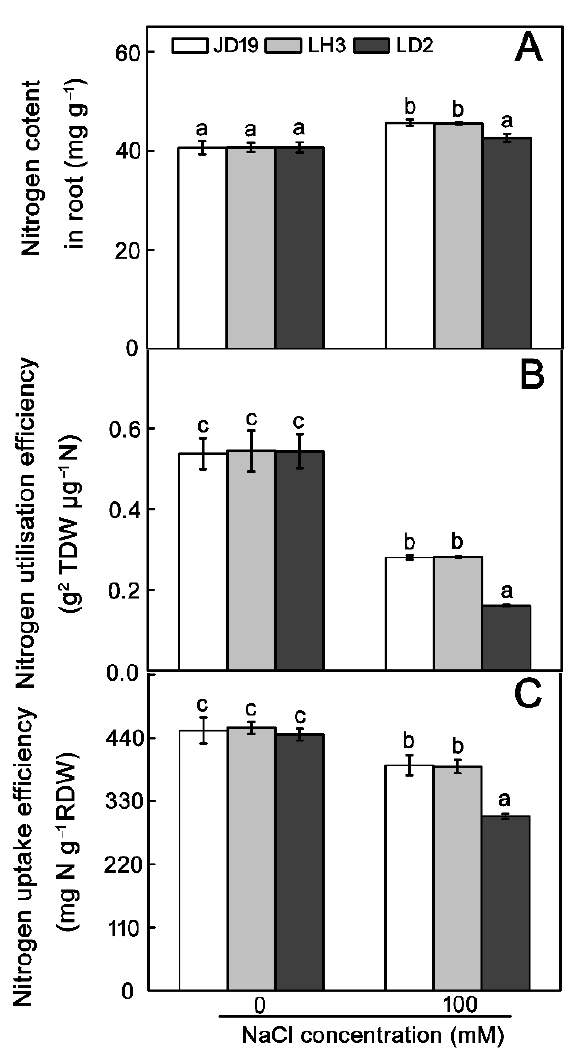
Figure 8. Effects of salt stress on N content ( A ), N utilization efficiency ( B ), and N uptake efficiency ( C ) of three soybean cultivars. TDW: total plant dry weight. RDW: root dry weight. Data are means ± SE (n = 3). Different letters indicate significant difference at p < 0.05.